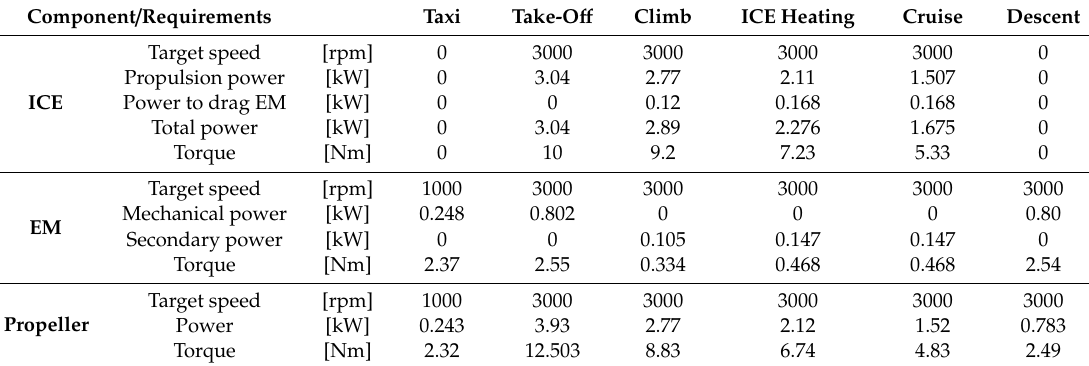
Table 3. Requirements for the real and the virtual test bench.